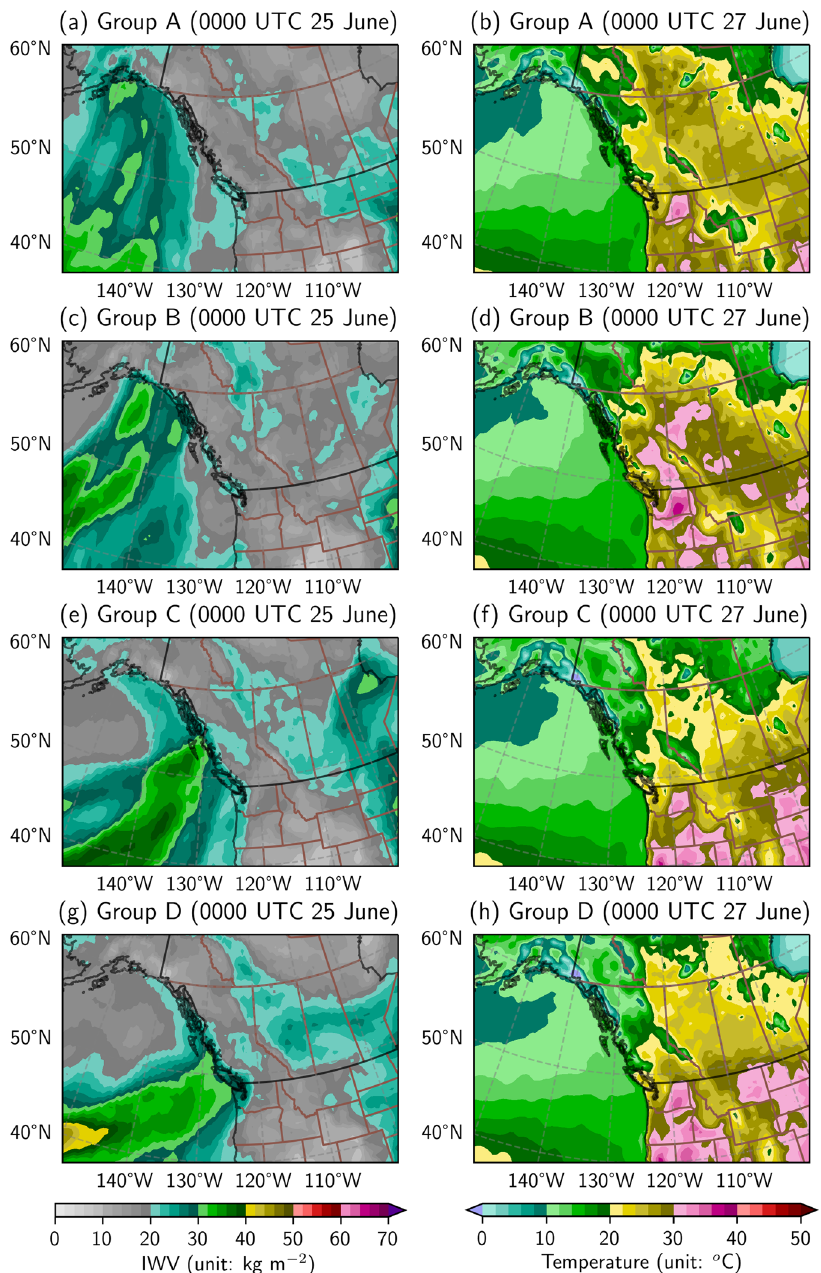
Fig. 10 Sub-ensemble mean predictions of IWV and T 2m with the ECCC GEPS run initialized at 0000 UTC 17 June 2021. The 21 ensemble members are grouped into four categories based on the similarities of their predicted IWV patterns valid at 0000 UTC 25 June. a , b Group A with 6 ensemble members. c , d Group B with 5 members. e , f Group C with 5 members. g , h Group D with 5 members. The group-mean IWV distributions valid at 0000 UTC 25 June (LT = 192 h) are plotted on the left panel. The group-mean T 2m valid at 0000 UTC 27 June (LT = 240 h) are plotted on the right